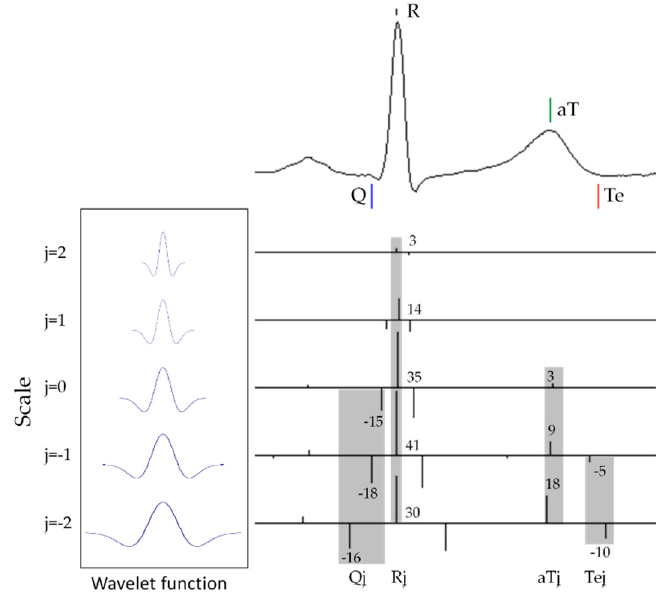
Figure 1. Example of a wavelet transformation of ECG.